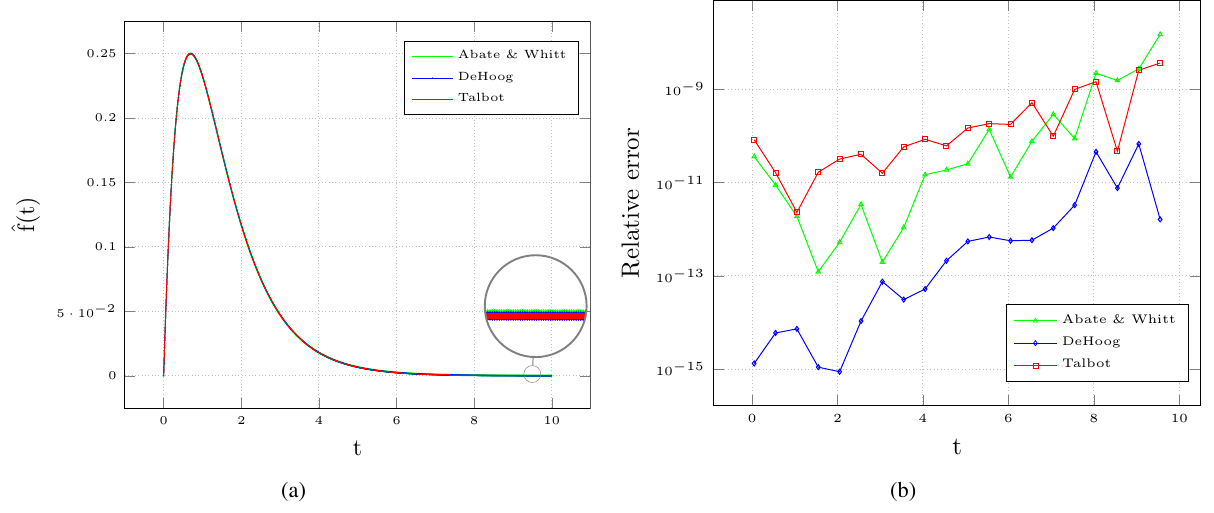
Fig. 2 Plots of numerical inversions ˆ f ( t ) of the Laplace transform (2) (a) and their relative errors (b) for applied methods in interval ( 0 , 30 (cid:105) .